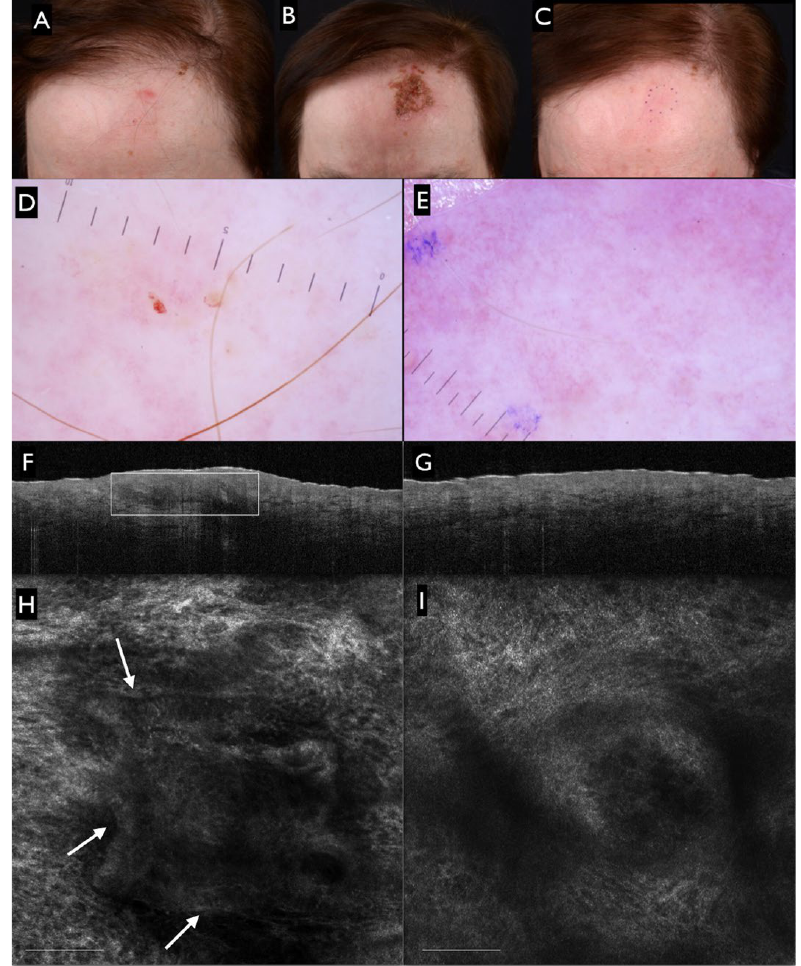
Figure 4. ( A ) Clinical image of a superficial basal cell carcinoma (BCC) from our center archive lo- cated on the left forehead of a 60-year-old woman, before initiating imiquimod 5% cream applied 5 times a week for 6 weeks. ( B ) Clinical image two months after the six-week cycle of treatment show- ing erythema, crusting and erosion. ( C ) Complete clinical healing of the lesion at the 18-month fol- low-up visit was observed. ( D ) Dermoscopic image of the superficial basal cell carcinoma (BCC) showing small erosions at the baseline and ( E ) after imiquimod treatment. Dermoscopic clearance was observed at the 18-month follow-up. ( F ) Corresponding OCT image shows ovoid structures protruding from the epidermis (white rectangular area) at the baseline and ( G ) complete OCT clear- ance at the 18-month follow-up (image size 6 mm × 2 mm). ( H ) RCM image shows tumor cords (white arrows) of the BCC at the baseline ( I ), which were no longer observed at the 18-month follow- up (scale bar 100 µm), confirming the RCM clearance.